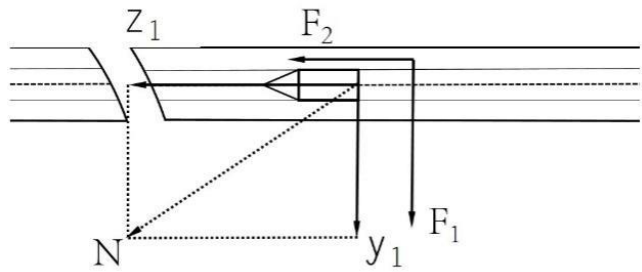
F and axis force F . 1 2